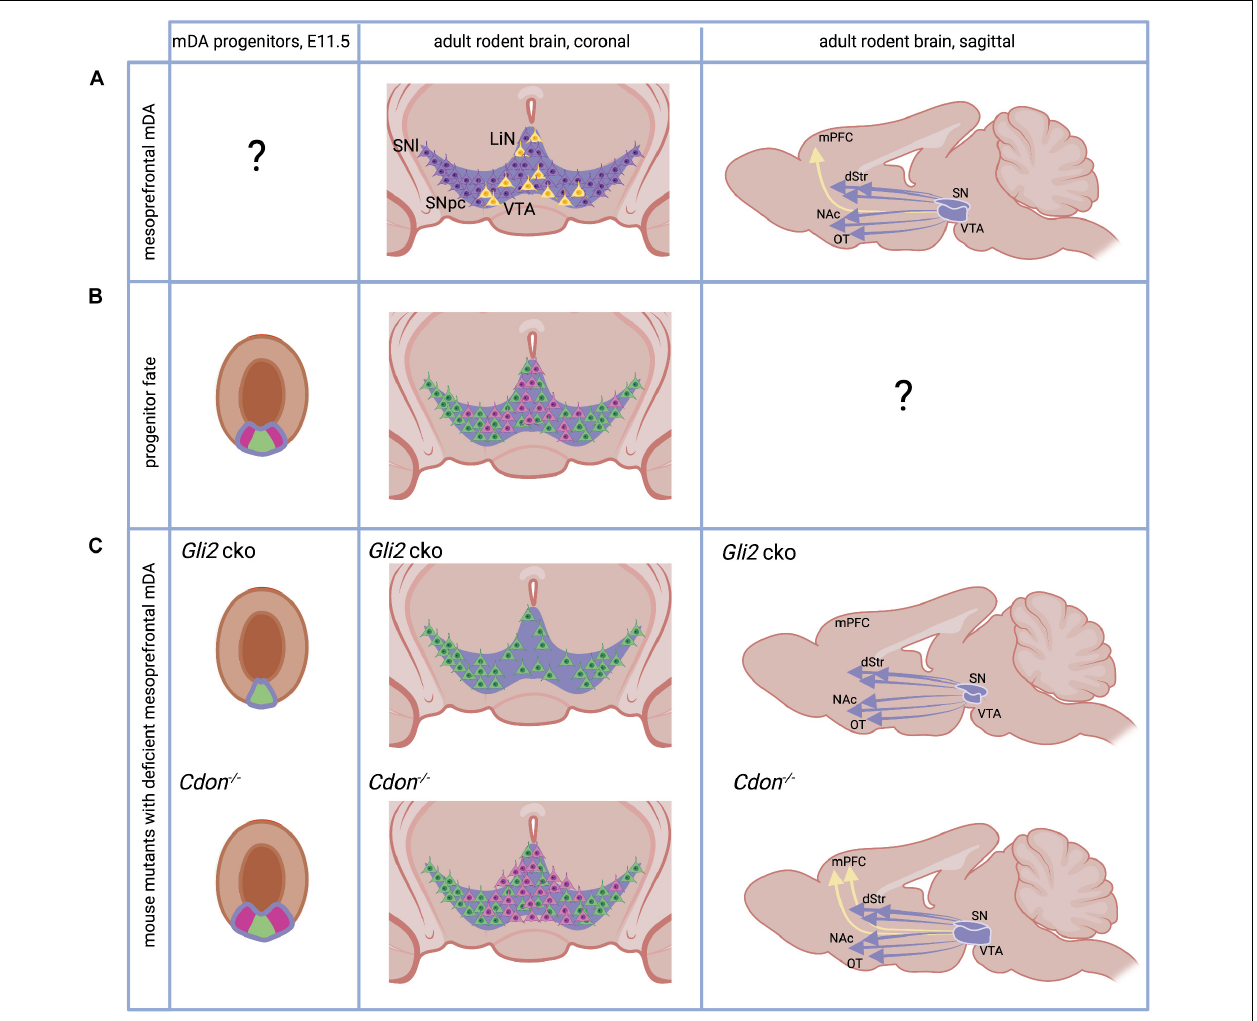
FIGURE 1 | The adult and developing mesoprefrontal DA system in rodents . (A) Localization of mesoprefrontal mDA neurons (yellow) in the adult ventral midbrain (coronal view) and their projections (yellow arrow) to the adult medial PFC (mPFC, sagittal view). Non-mesoprefrontal mDA neurons and projections are in purple. Note that it is unknown whether there are specific mesoprefrontal mDA progenitors (indicated by “?”). (B) The mDA progenitor domain (purple outline) is divided in a medial (green) and lateral (pink) domain based on gene expression. Progenitors from these two domains give rise to mDA neurons with different anatomical location in the adult brain (pink and green neurons in coronal view). Note that it has not been examined whether mDA progenitors from these two domains form specific subcircuits in the DA system (indicated by “?”). (C) Mice with alterations in the SHH signaling pathway have an altered mesoprefrontal DA system. Conditional inactivation of GLI2 ( Gli2 cko) results in loss of the lateral progenitor domain, a reduced number of VTA neurons and loss of mesoprefrontal DA projections. Inactivation of CDON ( Cdon − / − ) results in increased proliferation of mDA progenitors, an increased number of VTA neurons and increased DA release in the mPFC. See main text for details. dStr, dorsal striatum, NAc, nucleus accumbens, OT, olfactory tubercle. Created with